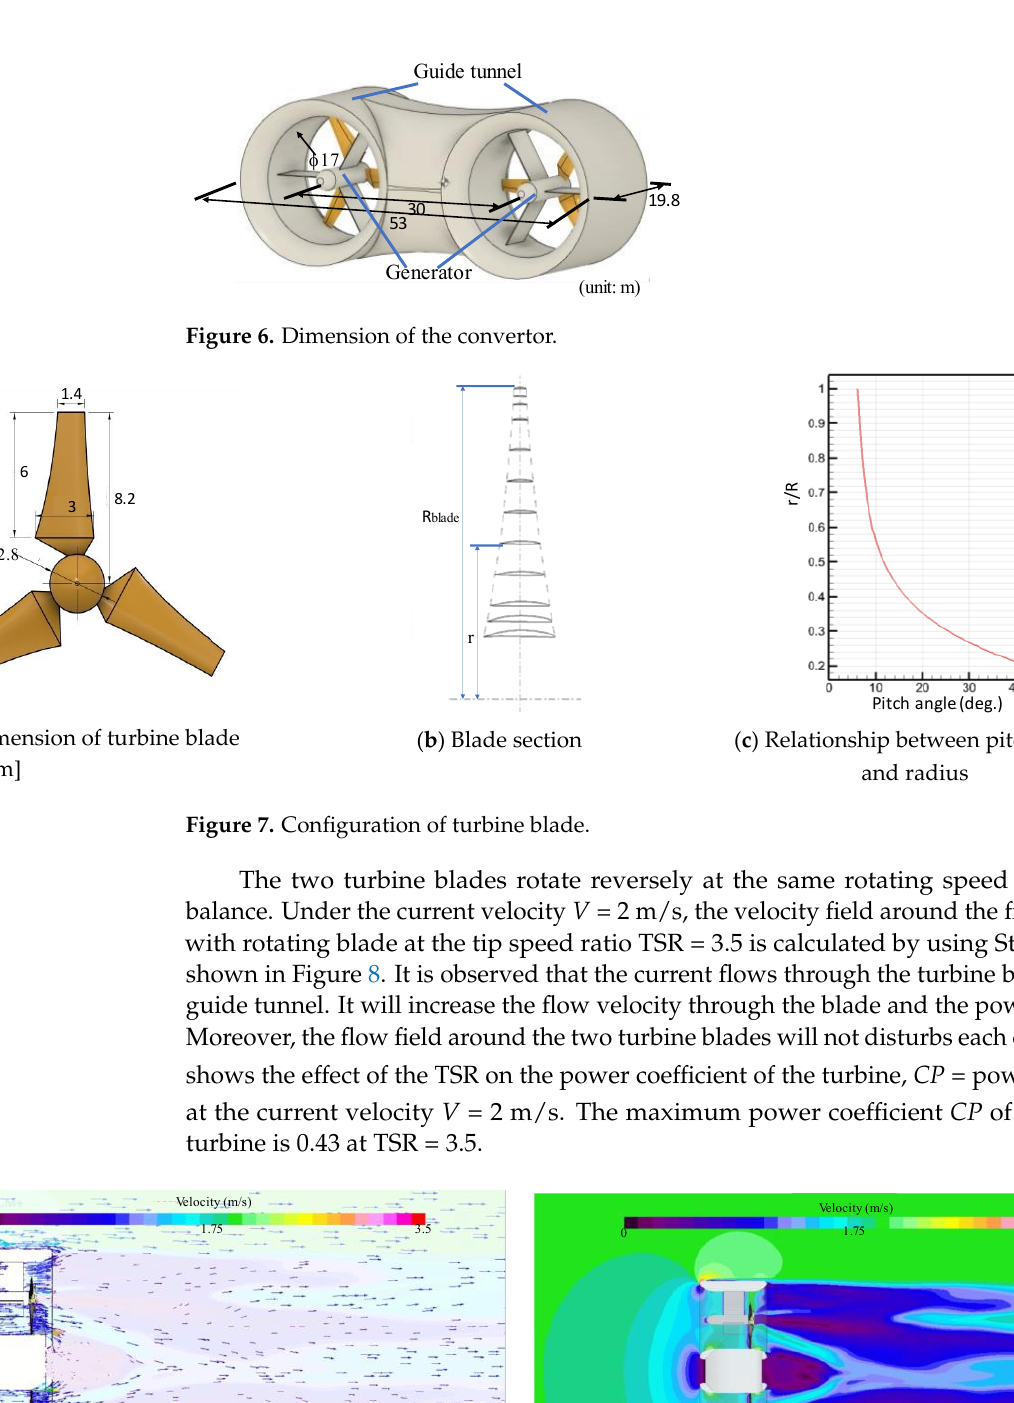
Figure 9. Relationship between CP and TSR of turbine.